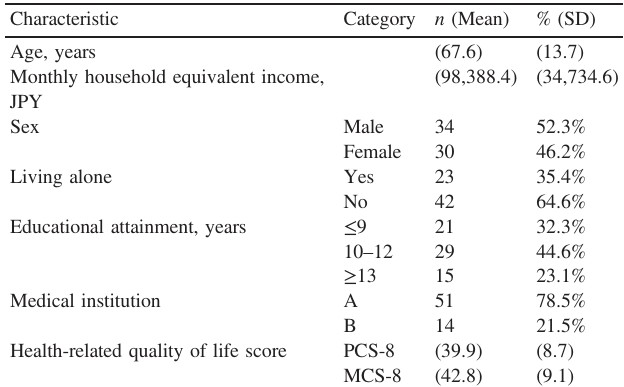
Table 1. Baseline characteristics of patients eligible for the Free